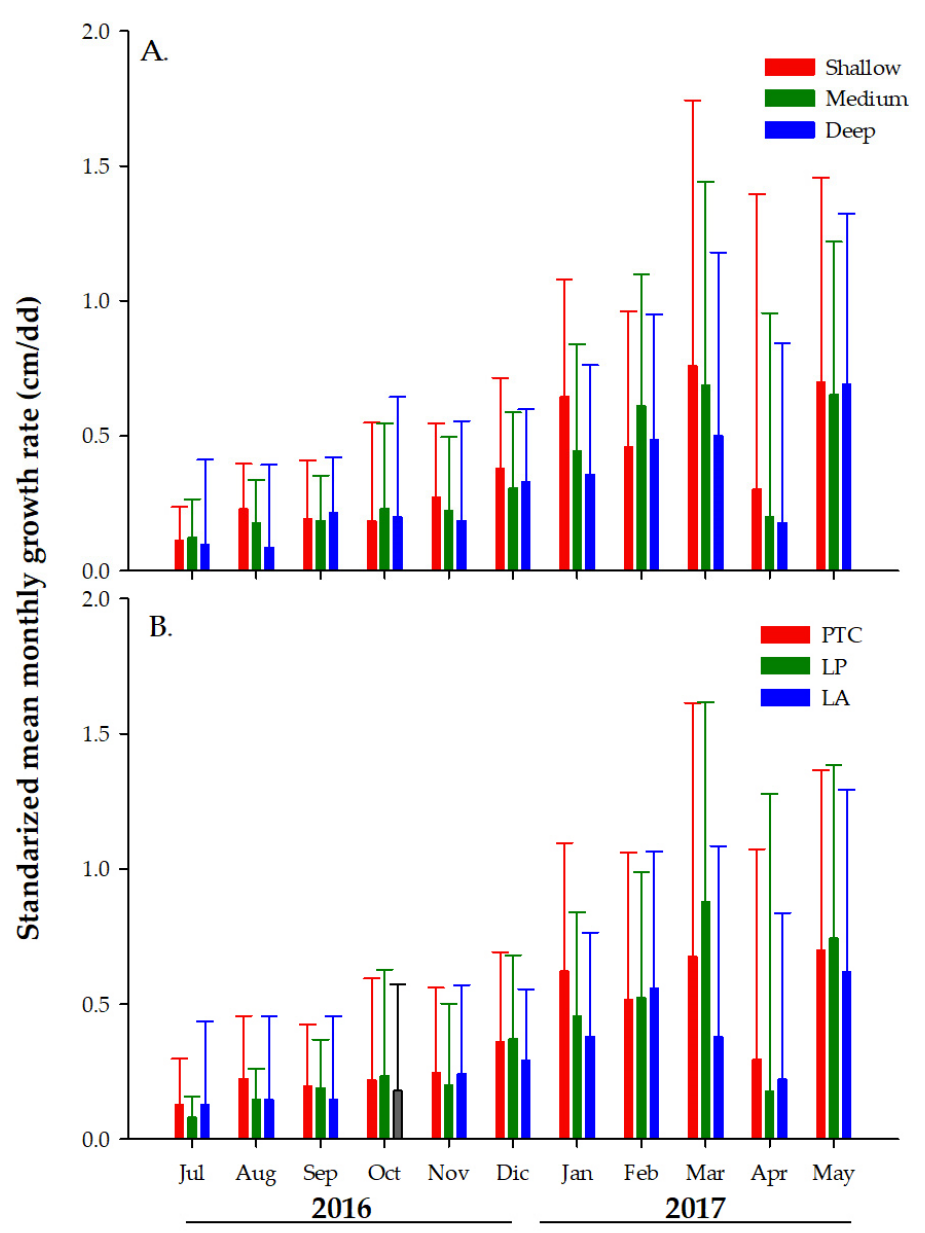
Figure 7. Comparison of the monthly growth rate of Acropora cervicornis fragments by farm depth ( A ) and site of fragment collection ( B ). Punta Tamarindo Chico (PTC), Luis Peña (LP), and La Ahogá (LA). N = 135 fragment individuals per depth/site. Bars represents monthly average and whiskers standard error.